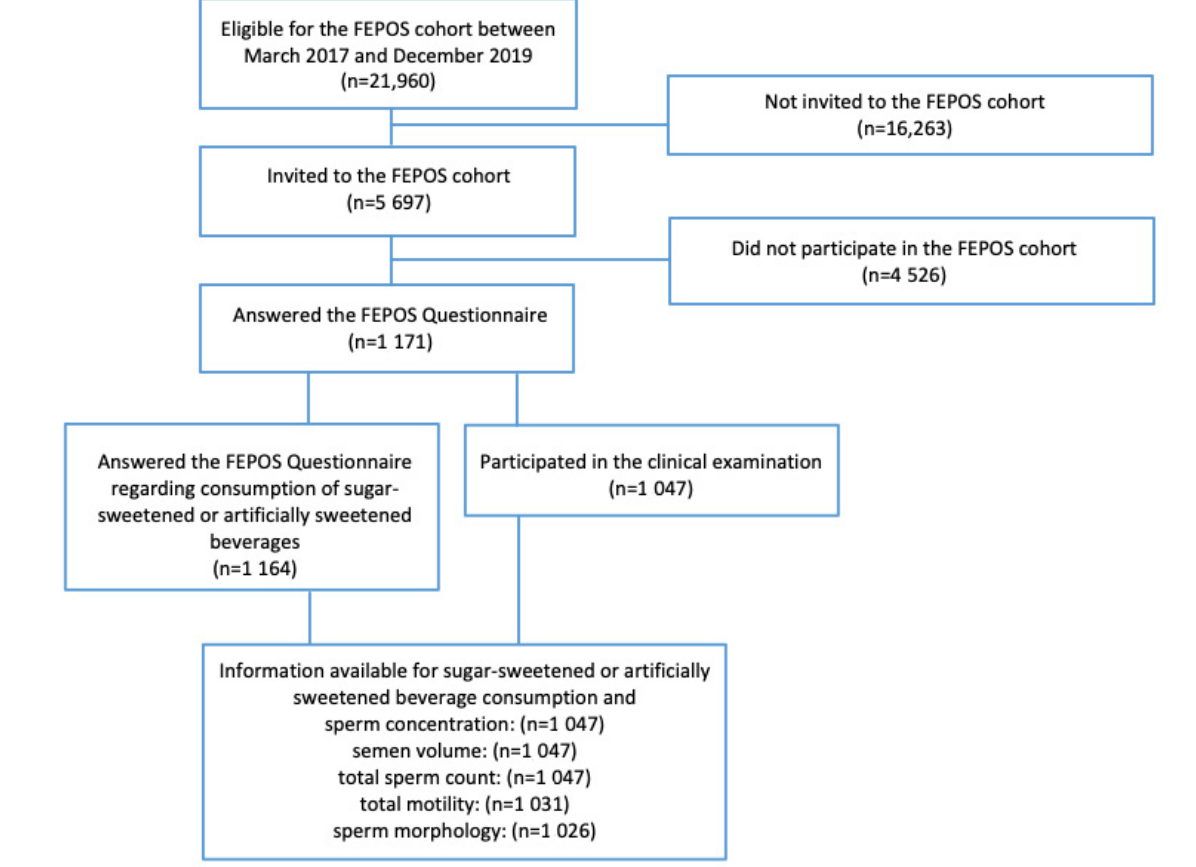
Figure 1. Flowchart of the FEPOS cohort, 2017–2019.